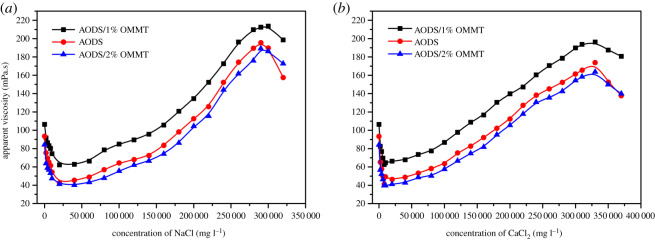
Effect of (a) NaCl and (b) CaCl2 concentration on apparent viscosity of sample solutions (T = 25°C).